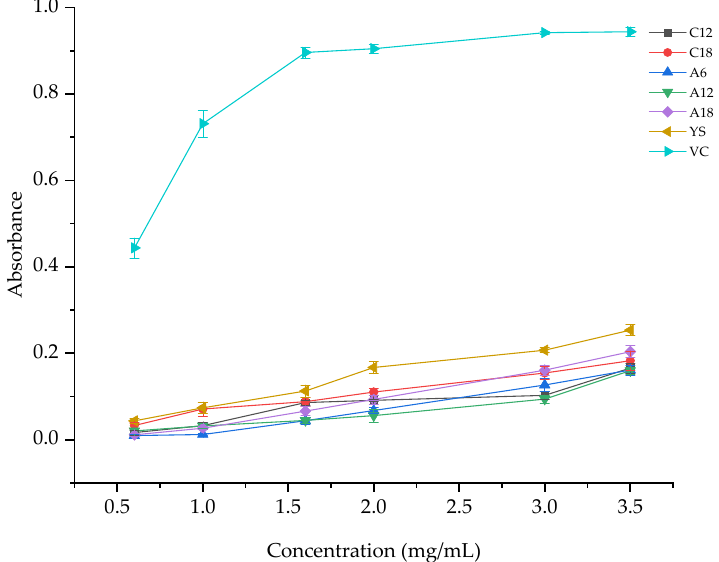
Figure 4. Total reducing power variation with extract concentration (C12 and C18 represented agarwood produced by A. crassna after 12 and 18 months of inoculation, respectively; A6–A18 represented agarwood produced by A. sinensis after 6, 12, and 18 months of inoculation, respectively; YS and VC represented wild agarwood and ascorbic acid, respectively).